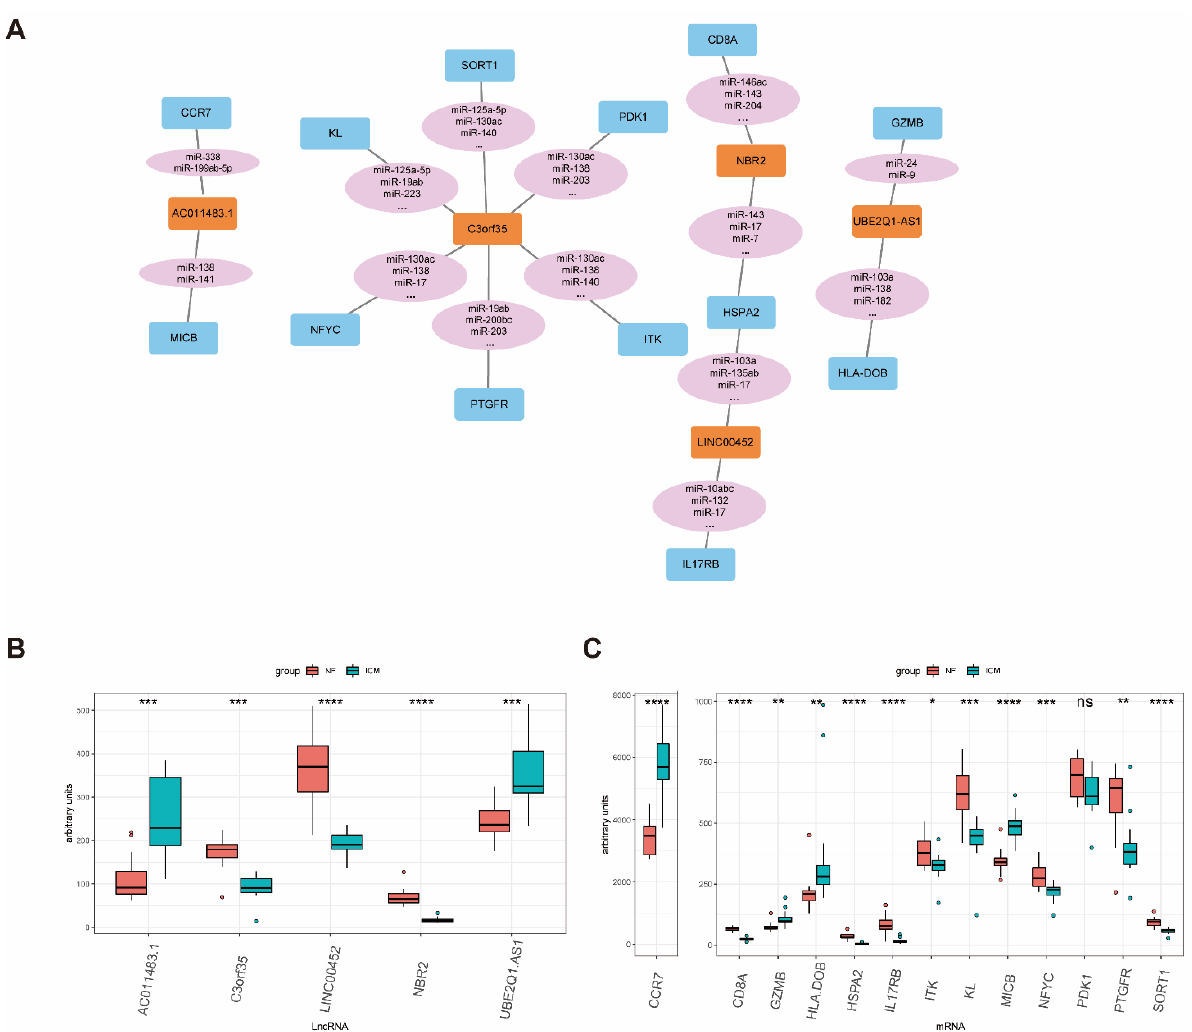
Figure 3. The immune-related ceRNA network within the key modules. ( A ) The immune-related ceRNA network. The blue nodes represent mRNAs, the pink nodes represent miRNAs, and the orange nodes represent lncRNAs. ( B ) Expression of lncRNAs included in ceRNA network among the ICM and NF samples in the training GSE116250 dataset. ( C ) Expression of mRNAs included in ceRNA network among the ICM and NF samples in the training GSE116250 dataset. ICM, ischemic cardiomyopathy; NF, non-failing heart. * p value < 0.05, ** p value < 0.01, *** p value < 0.001, **** p value < 0.0001.